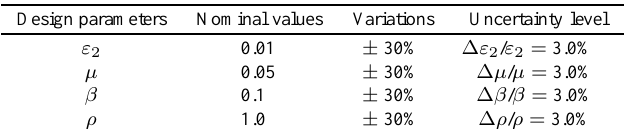
Table 2 Design variables and their admissible variations and uncertainties